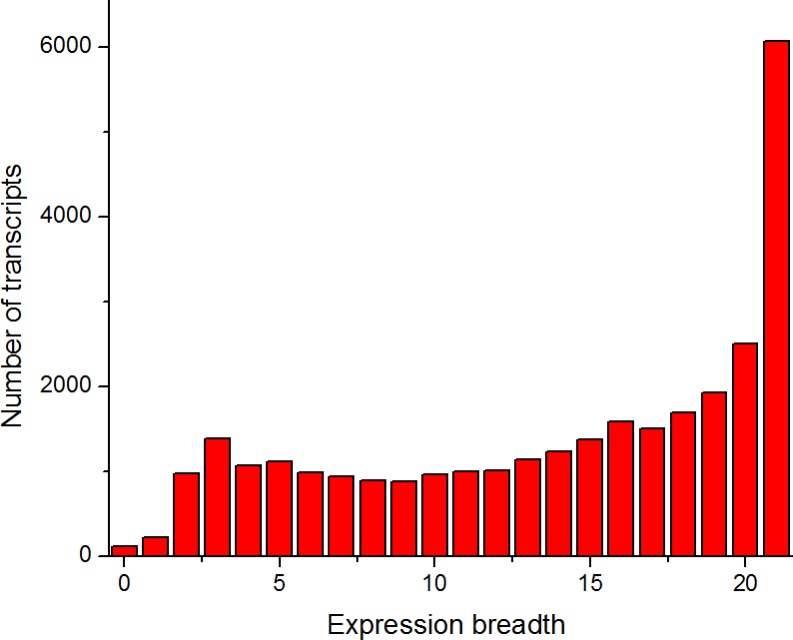
 Number of tissues where a given transcript was detected.The expression breadth (horizontal axis) denotes the number of tissues where a given transcript was detected. The zero value of the expression breadth indicates undetected transcripts.